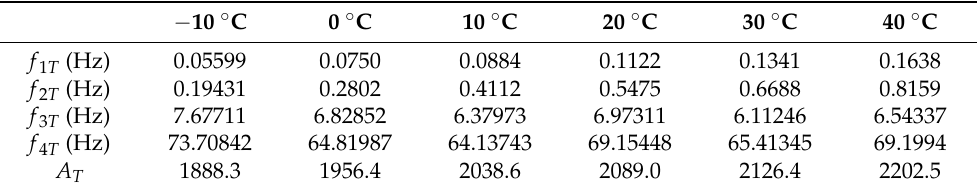
Figure 7. The method of fitting the open-loop transfer function. Table 2. The pole frequency distribution and sensitivity coefficients for open-loop sensitivity curves at different temperatures.